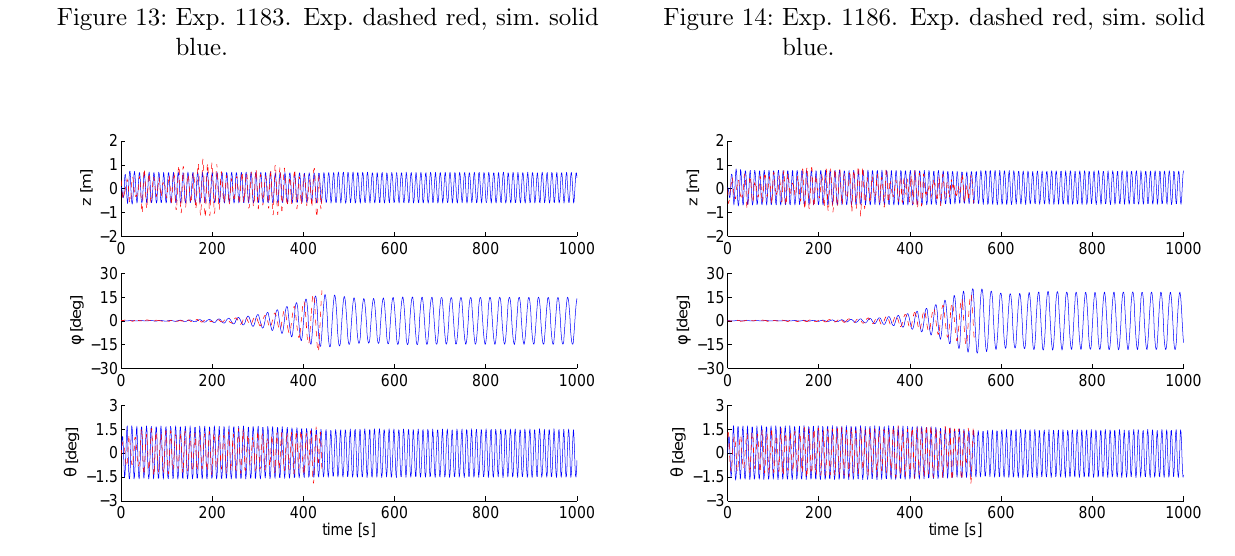
Figure 15: Exp. 1184. Exp. dashed red, sim. solid blue.